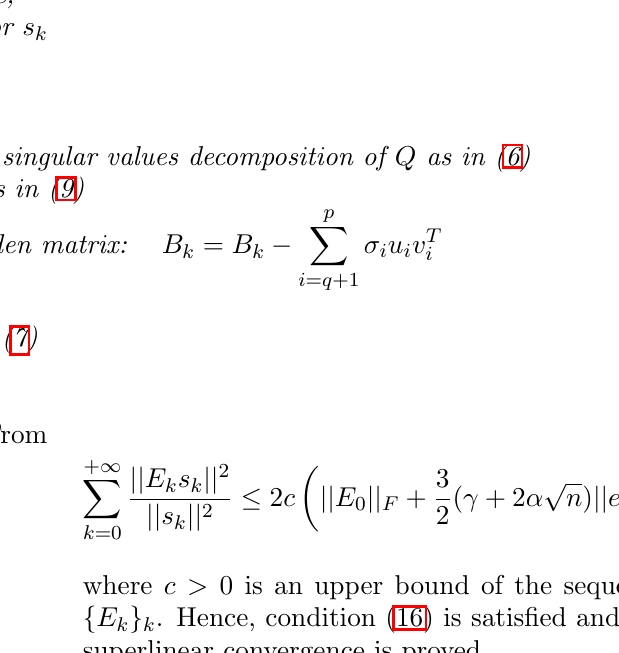
Algorithm 1. Let x Let m = 0